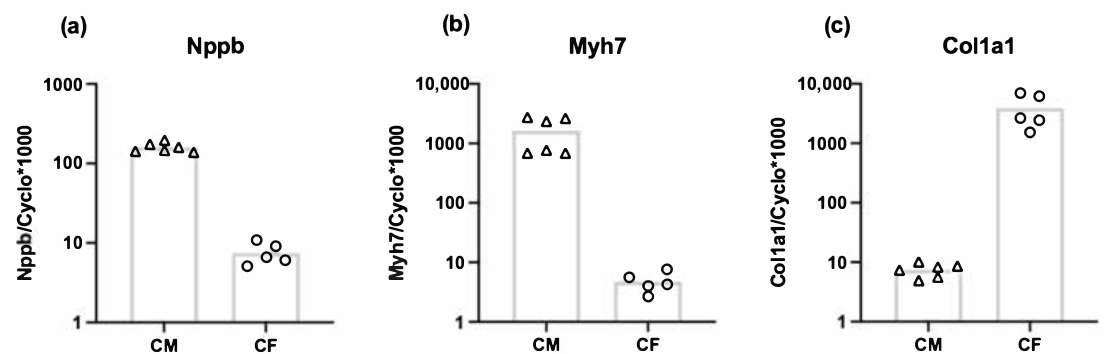
Figure 3. Relative mRNA expression levels of Nppb ( a ) Myh7 ( b ) and Col1a1 ( c ) in cardiomyocytes (CM) ( n = 6) and cardiac fibroblasts (CF) ( n = 5) (presented on a logarithmic scale). Bar indicates mean.